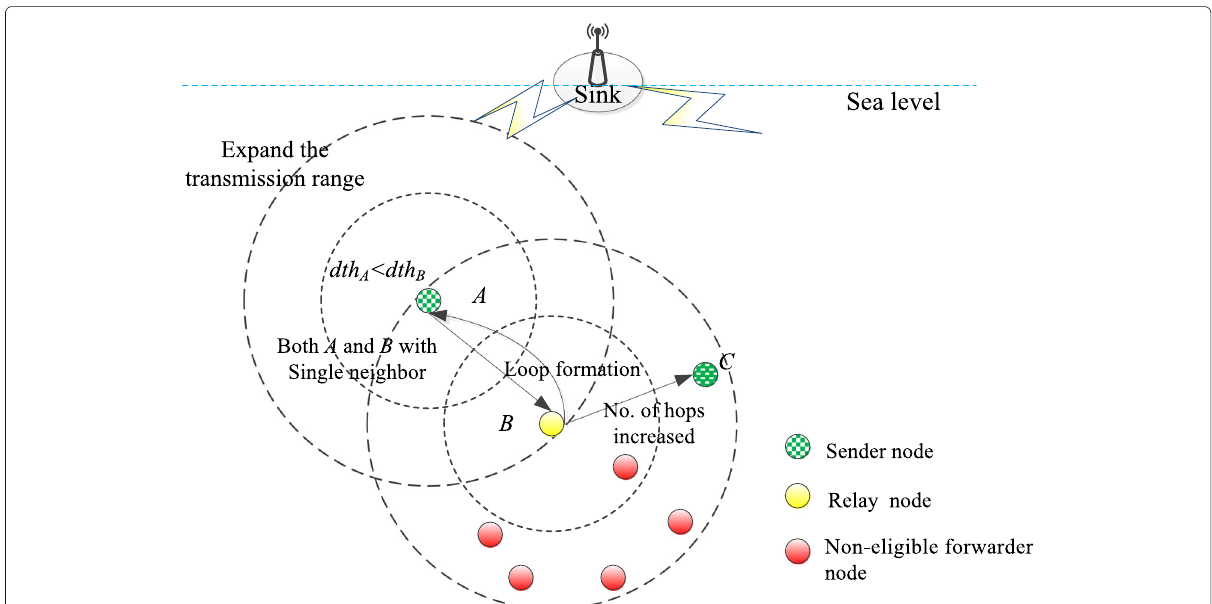
Fig. 7 Routing problems during data transmissions. Formation of loops during data transmissions without using depth of the neighbors